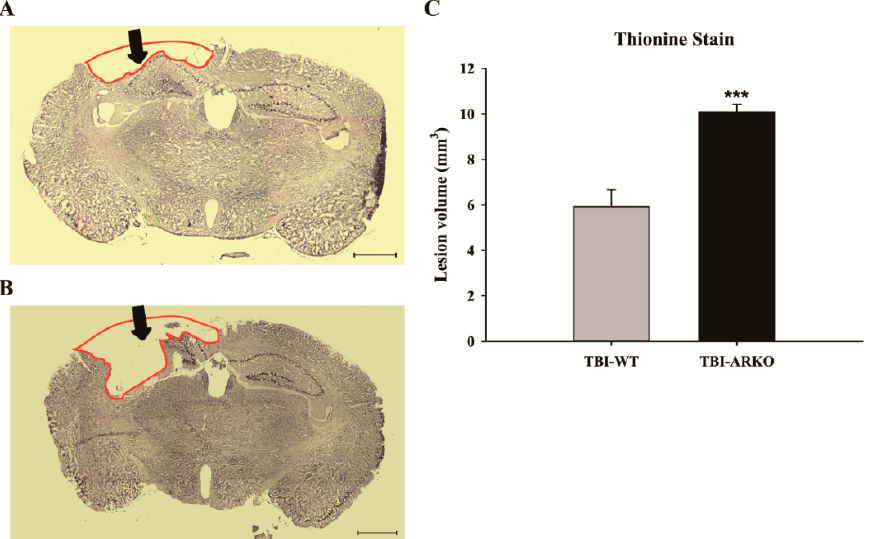
Figure 6. Androgen receptor deleted mice show a larger brain lesion volume than the WT following TBI. Thionine stained section of WT mice ( A ) and ARKO mice ( B ) brain after TBI. The black arrows indicate the impact site of TBI, 21 days following the injury. Red lines illustrate the lesioned area. (Images: x25 magnification, scale bar = 1 mm) ( C ) The total brain lesion volume is calculated. Compared with the WT impacted with TBI, androgen receptor knockout significantly increases the lesion volume in ARKO mice. All data are presented as the mean ± standard error; *** p < 0.001 versus wild-type; n = 7 in each group.